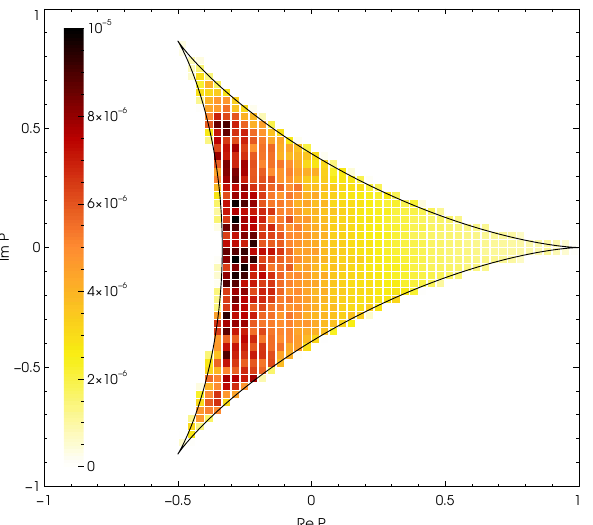
Figure 12. Density plot of the average local norm ψ † ψ of low Dirac modes in the Polyakov loop plane (here P = 1 tr P ) in the high-temperature phase. From Ref. [39]. (Figure adapted from 3 G. Cossu and S. Hashimoto, J. High Energy Phys. 06, 56 (2016), and used under a CC-BY 4.0 license